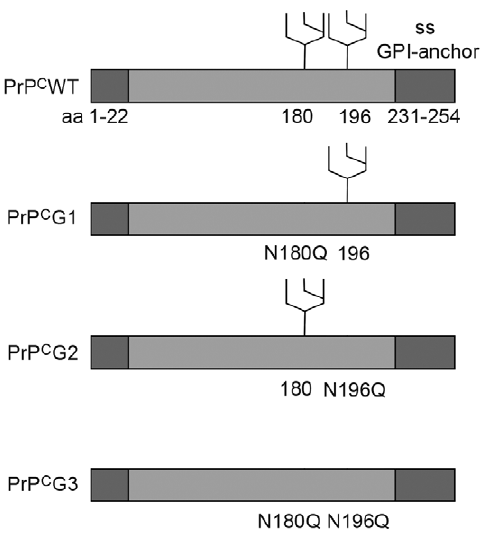
Figure 1. Schematic drawing of constructs used in this study. Shown are the maps of PrP C WT, PrP C G1, PrP C G2, and PrP C G3 with N- terminal signal sequence (ss) and C-terminal GPI-anchor signal (ss GPI- anchor) (dark boxes) and the mutations introduced to delete N- gylcosylation sites.